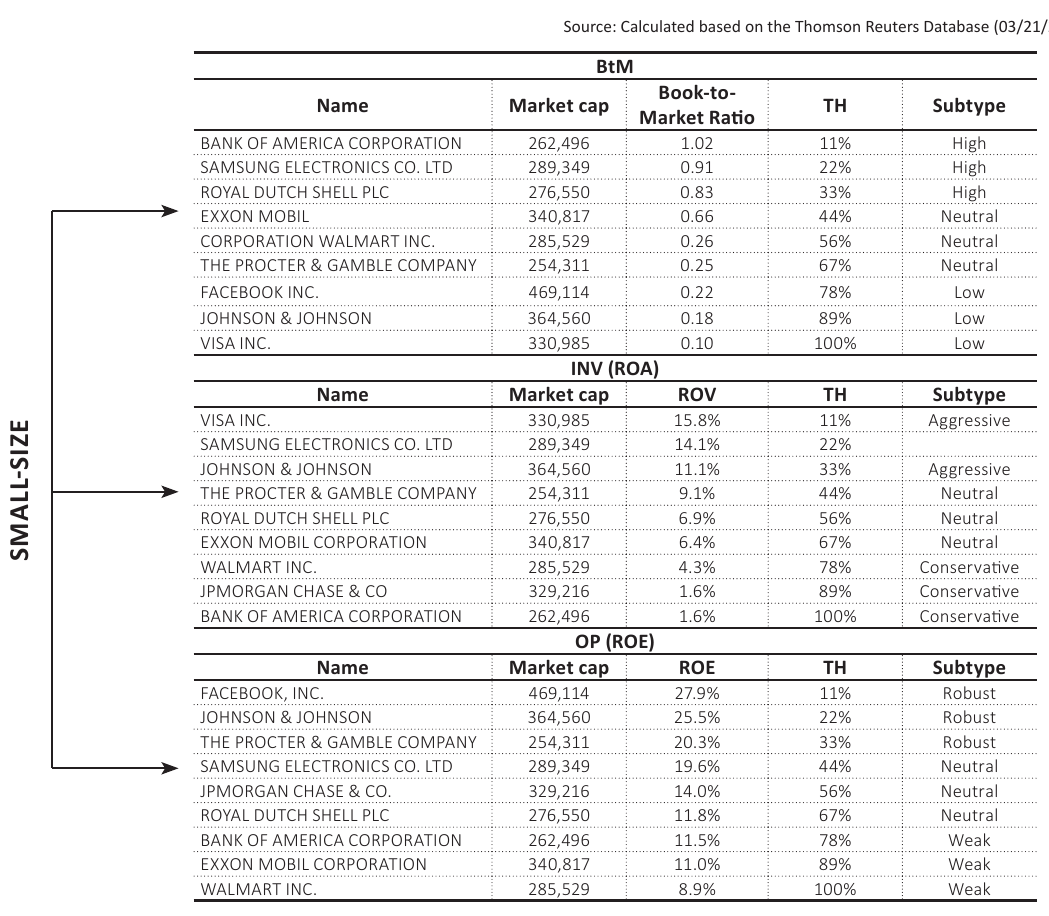
Figure 2. Share allocation across small-size